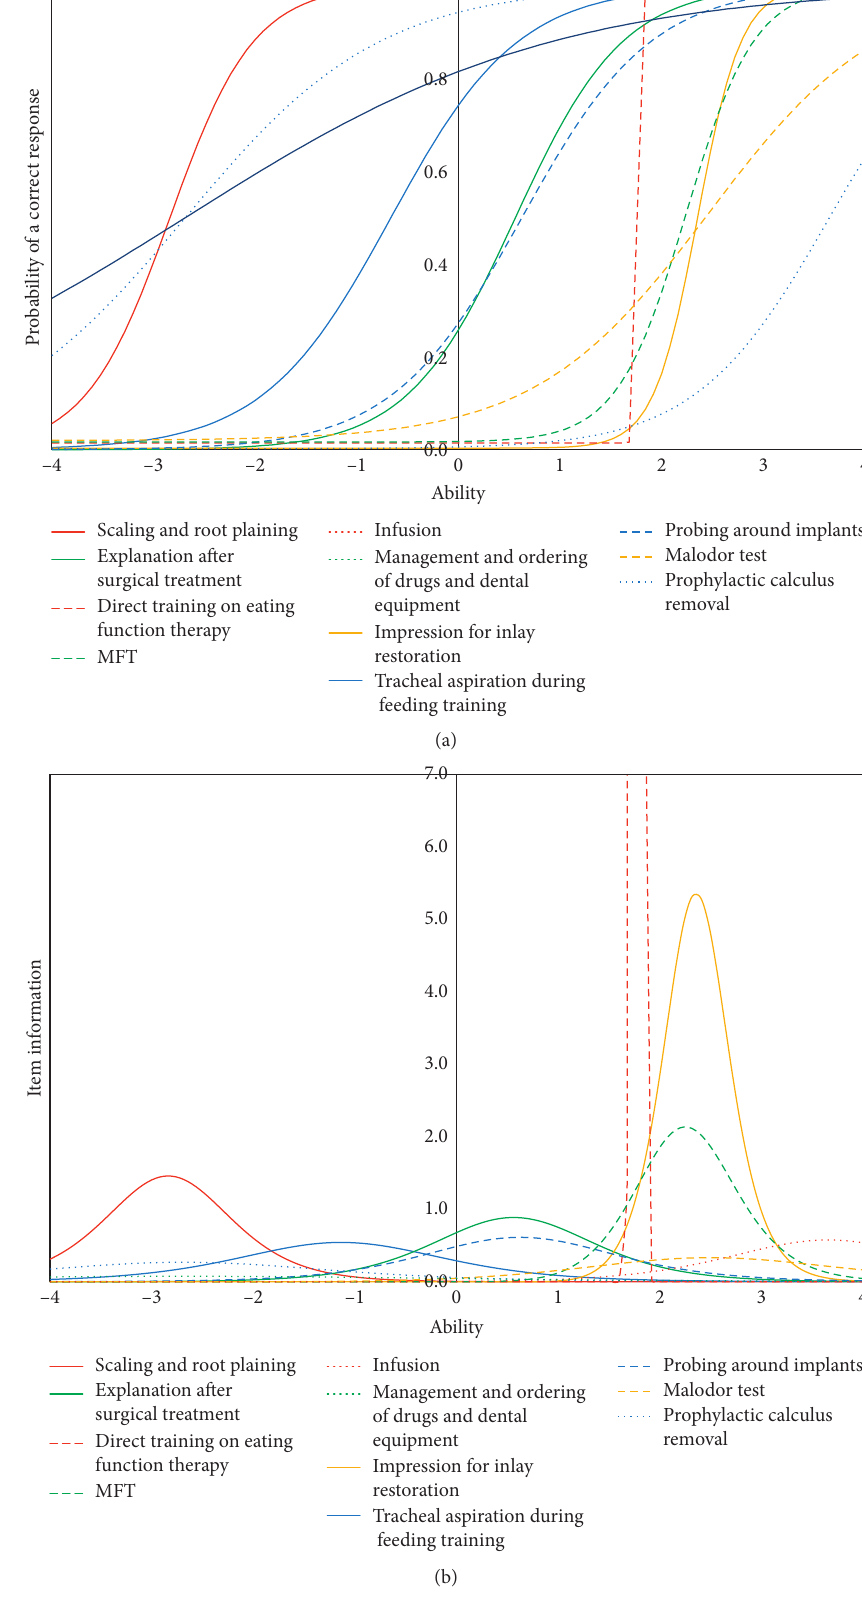
Figure 1: The item response curves and item information curves of the representative items from each cluster. The horizontal axis, known as ability according to item response theory, indicates the dental hygienists whoperformed a number of daily dental jobs. The vertical axis of the item response curve indicates the percentageof individuals whoperform eachwork-related task. Thevertical axis of the item informationcurve indicated theability of each item to distinguish the number of daily dental hygienist jobs. Details of the clusters are shown in Table